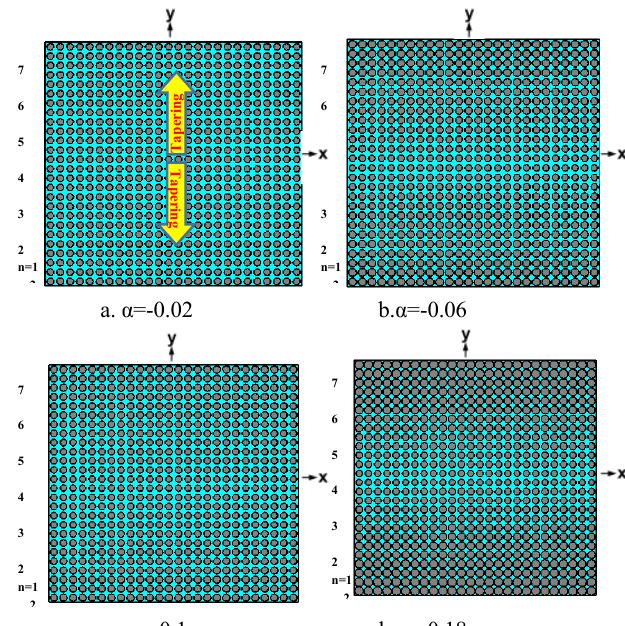
Fig. 6. The tapered holes from the central row-in one directions with different scaling coefficient, α, R o = 2.64 mm, n=1, 2…, 7 and ζ =1.